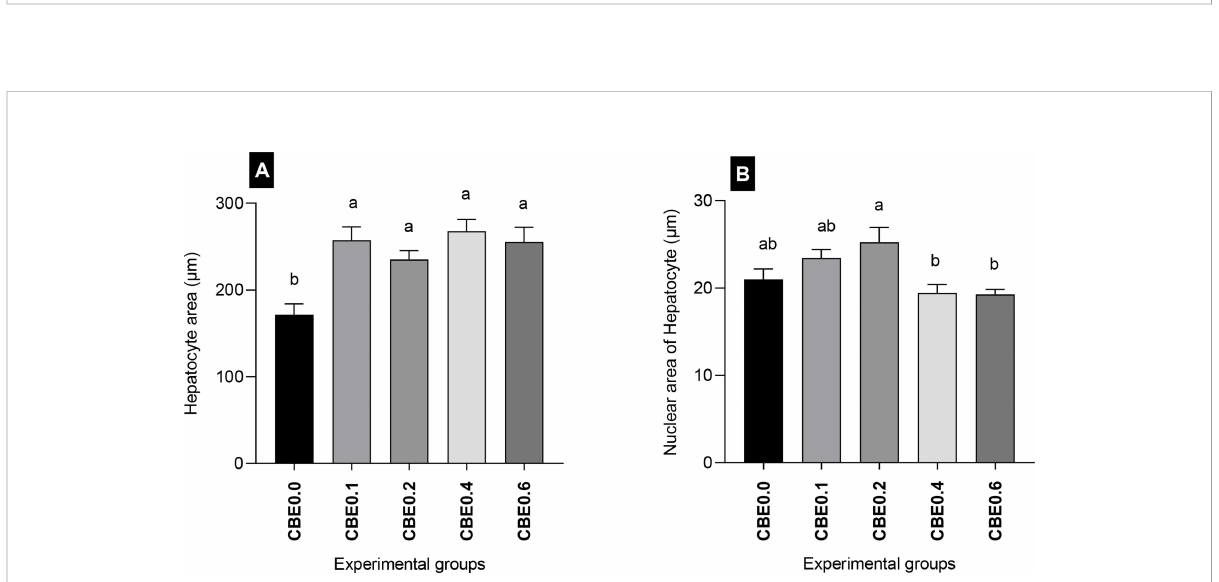
FIGURE 13 Morphometric analysis of liver in Nile tilapia groups fed different doses of CBE for 10 weeks. (A) The mean hepatocyte area ( m m). (B) Nuclear area of hepatocytes ( m m). Columns with different superscript letters in the same fi gure are signi fi cantly different (p ≤ 0.05) between different groups.